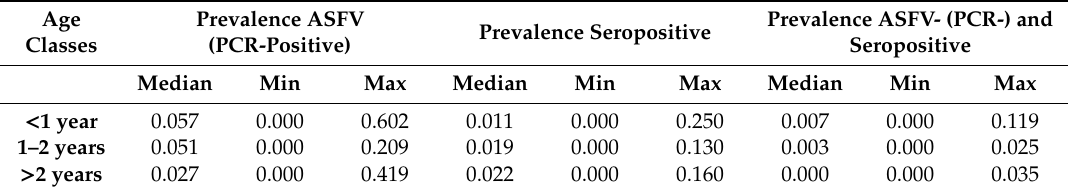
Table 2. Median, minimum, and maximum prevalence estimates for wild boar of three di ff erent age classes for the period January 2015–February 2020. The animals had tested positive by PCR, were seropositive or positive for ASFV, and had ASFV-specific